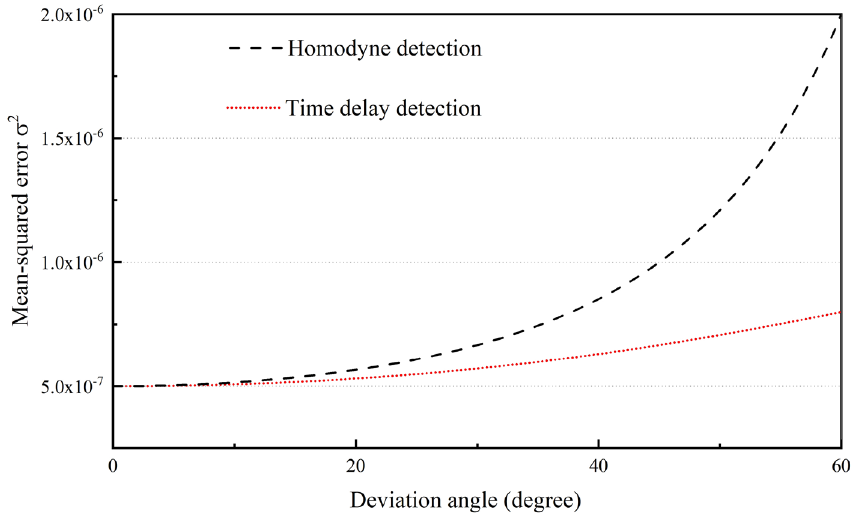
Figure 2. Comparison of the measurement accuracies of homodyne detection and time delay detection when the interference angle deviates from the optimal measurement point and the total photon flux remains the same 2 0.5 10 6 α at | | = ×